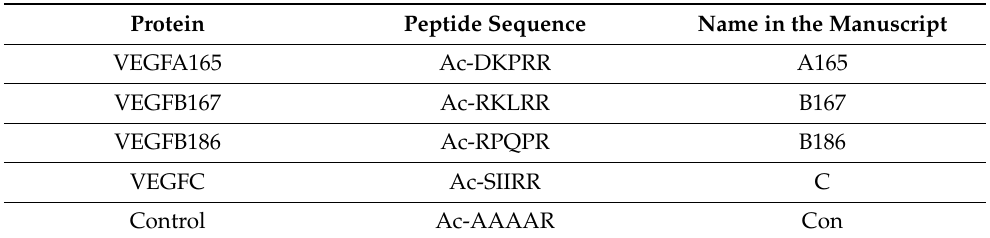
Table 1. Peptides used in the study. Ac denotes Acetyl-group. Protein Peptide Sequence Name in the Manuscript VEGFA165 Ac-DKPRR